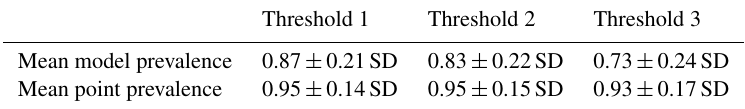
Table 2. Mean model and point prevalence for AOH maps with standard deviation of 420 mammal species across 3 different